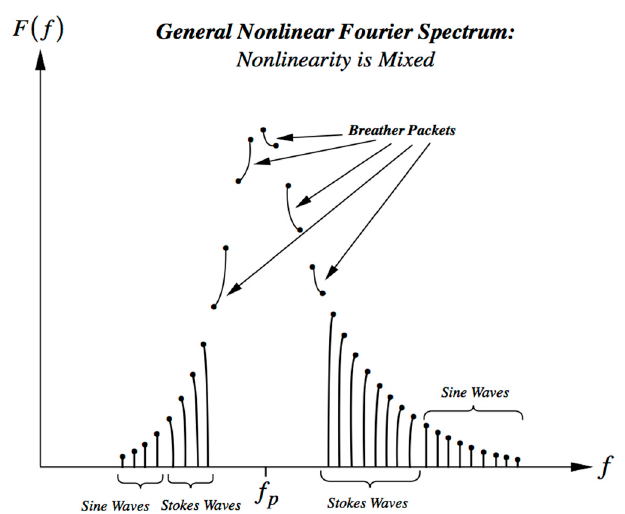
Figure 1. A typical nonlinear ocean wave spectrum has sine waves (in the right ‐ and left ‐ hand tails), Stokes waves (at intermediate amplitudes) and breathers (clustered about the peak of the spectrum). The black dots are “simple point eigenvalues” and the black lines are “spines” (Osborne [1]). When the spines connect an eigenvalue to the frequency axis one has sine or Stokes wave components (Osborne et al. [5]). When one has spines that directly connect two points of spectrum above the frequency axis, one has a breather component. The large peak of the spectrum indicates high nonlinearity (large BF parameter), and is dominated by five breathers.